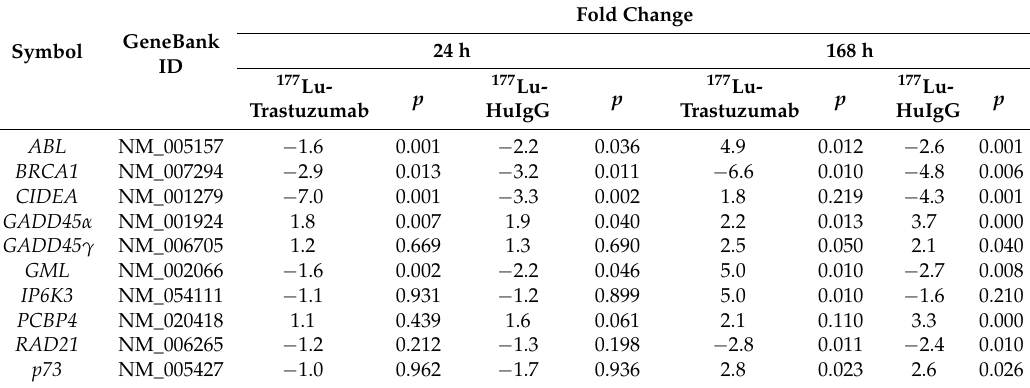
Table 2. Expression of genes involved in apoptosis in LS-174T i.p. xenografts following treatment with 177